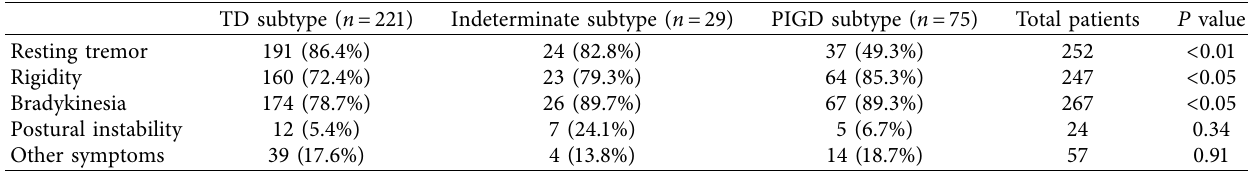
Table 2: Types of symptoms present at diagnosis.